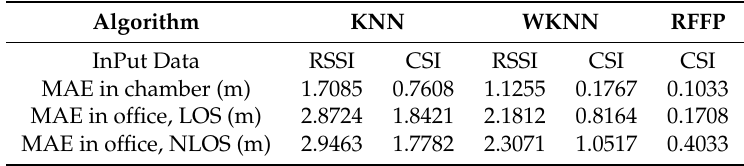
Table 1. Performance comparison between different algorithms and input data.